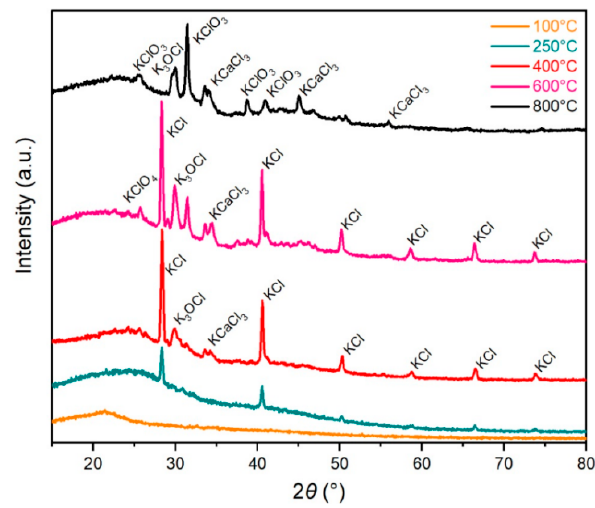
Figure 7. X-ray di ff raction (XRD) pattern of the heat-treated carrot in dependence on the heat Figure 7. X-ray diffraction (XRD) pattern of the heat-treated carrot in dependence on the heat treatment treatment temperature.